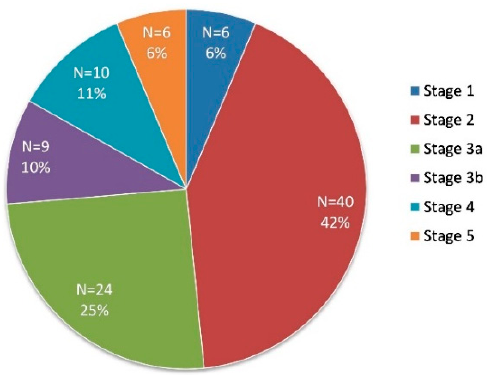
Figure 1. Proportion of patients in each stage of diabetic chronic kidney disease (CKD). The beta diversity indices are used to describe ecological diversity between microbial community samples. The beta diversity of the gut microbiome did not significantly differ between early versus late groups of diabetic CKD individuals or between each of the stages of diabetic CKD when compared with another (PERMANOVA, p value = 0.70, Figure 2A,B).